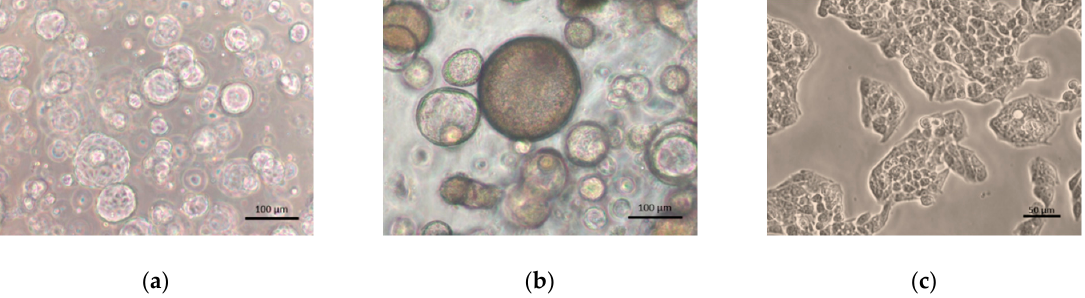
Figure 1. Morphology of cultured hepatocyte systems. ( a ) Three-dimensional human liver organoids on day 21 in expansion medium (EM); ( b ) 3D human liver organoids on day 9 in differentiation medium (DM); ( c ) HepG2 cells grown in monolayer culture. Original magnifications, ×100 ( a , b ) and ×200 ( c ). Bar indicates 100 μ m ( a,b ) and 50 μ m ( c ).